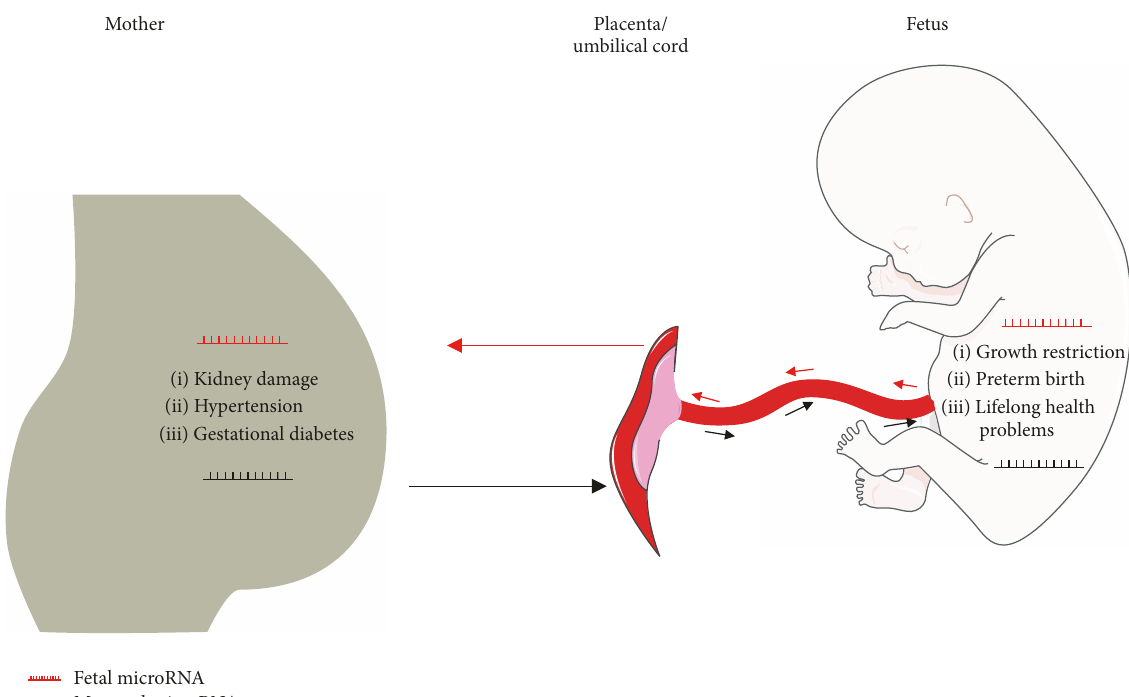
Figure 3: The mutual communication of miRNAs between fetus and mother in the pregnancy may link to most pregnancy-associated maternal and fetal disorders. The aberrant exchange of fetal and maternal miRNAs during pregnancy may even lead to lifelong problems in the fetus and